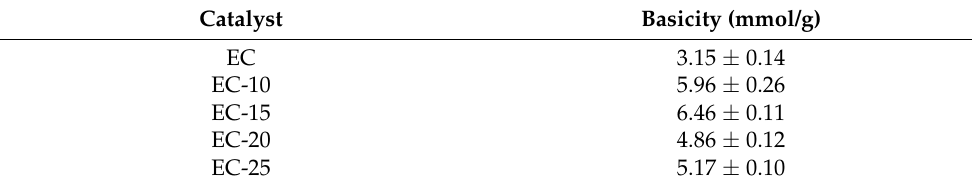
Table 3. Basicity analysis.